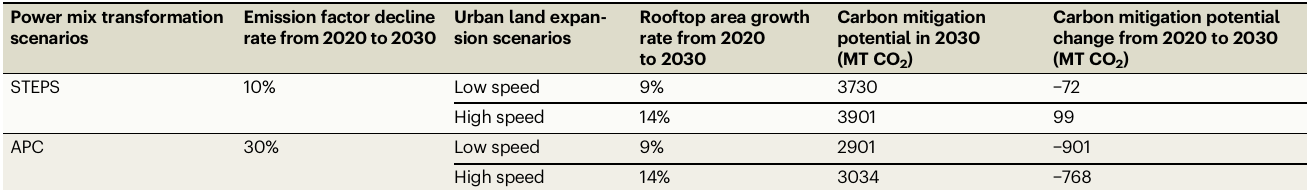
Table 1 | Future changes in rooftop carbon mitigation potential under different urban land expansion and power mix trans- formation scenarios Power mix transformation